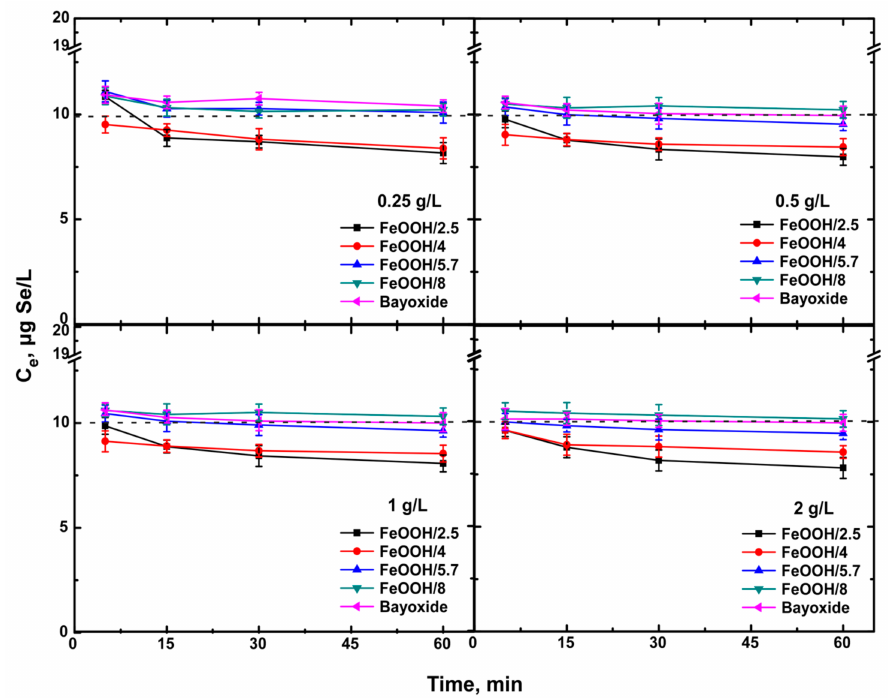
Figure 2. Adsorption of selenium species onto several FeOOHs (used as adsorbent media) in relation to the adsorbent dose and contact time. Experimental conditions: the initial concentration of Se in the samples is a mixture containing 10 µ g Se(IV)/L and 10 µ g Se(VI)/L (i.e., total Se 20 µ g/L), pH 7.3 ± 0.2, and temperature 20 ◦